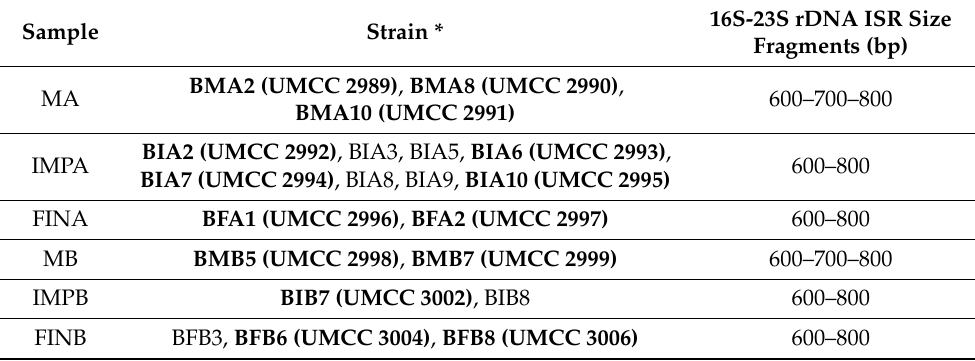
Table 4. PCR amplification of the 16S-23S rDNA intergenic spacer region